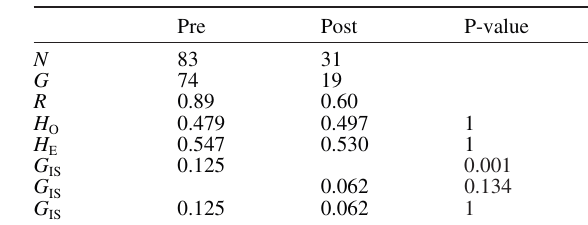
), ex- O ). P-values IS